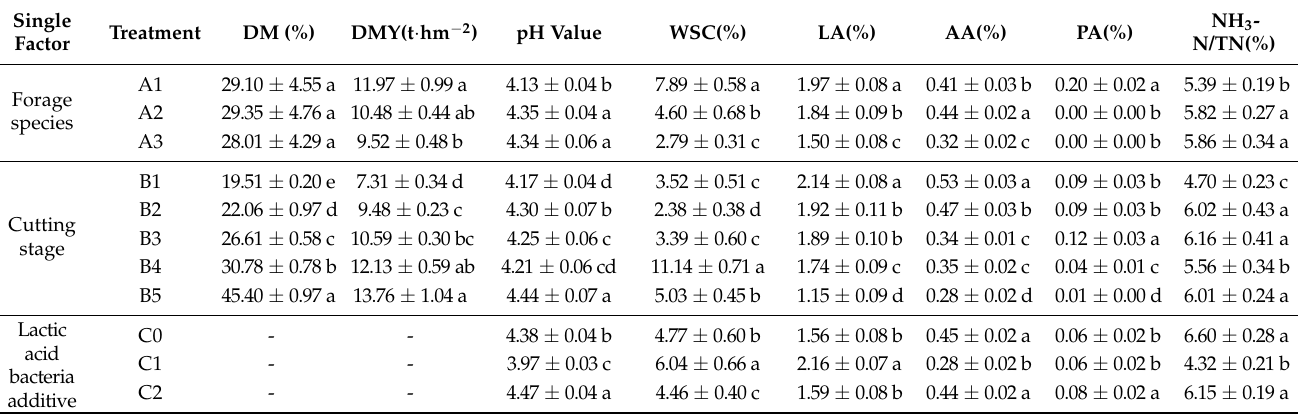
Table 2. Differences in the average DM, DMY and silage fermentation quality within the forage species, cutting stage and lactic acid bacteria